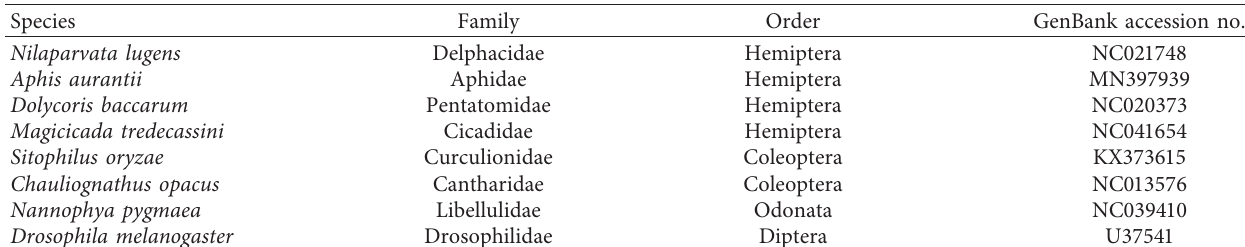
Table 1: Insect taxa used in the phylogenetic analysis based on the entire mitochondrial genome.